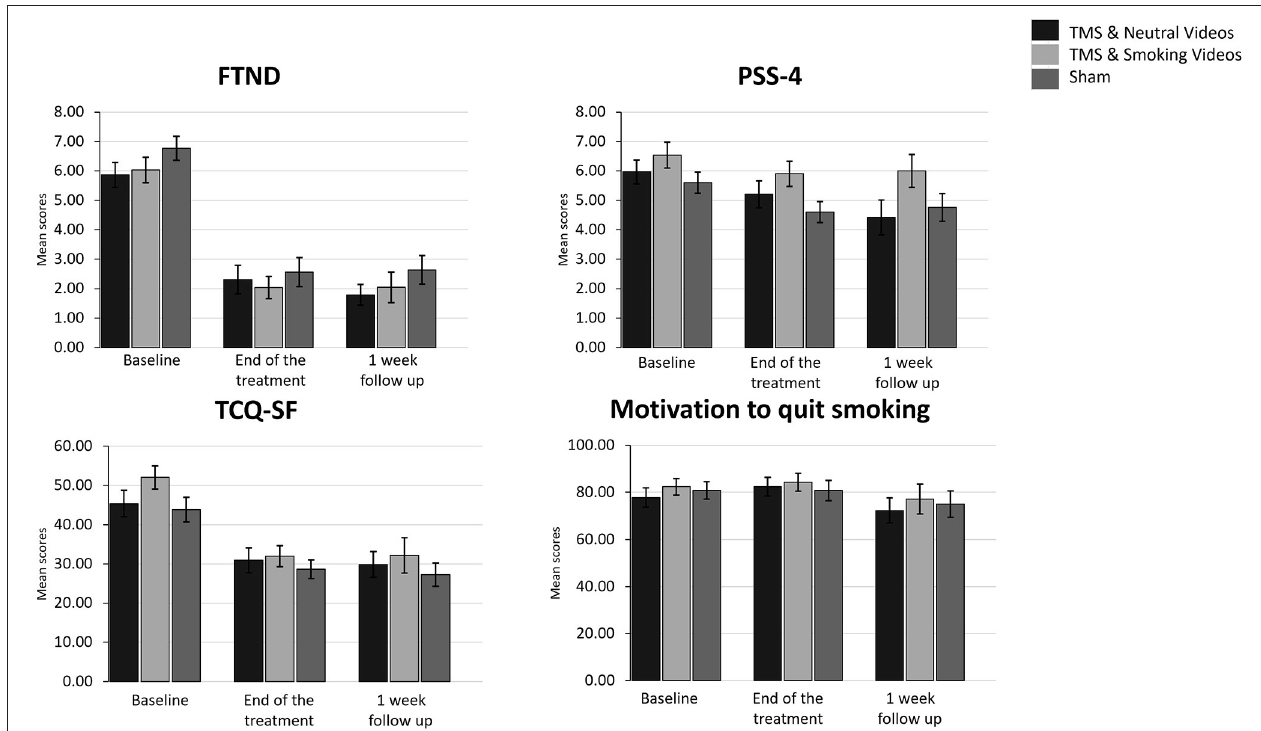
FIGURE 3 | Bar graphs showing difference in mean scores of FTND, PSS-4, TCQ-SF and Motivation to quit smoking over time. Data are presented as mean ± SEM.